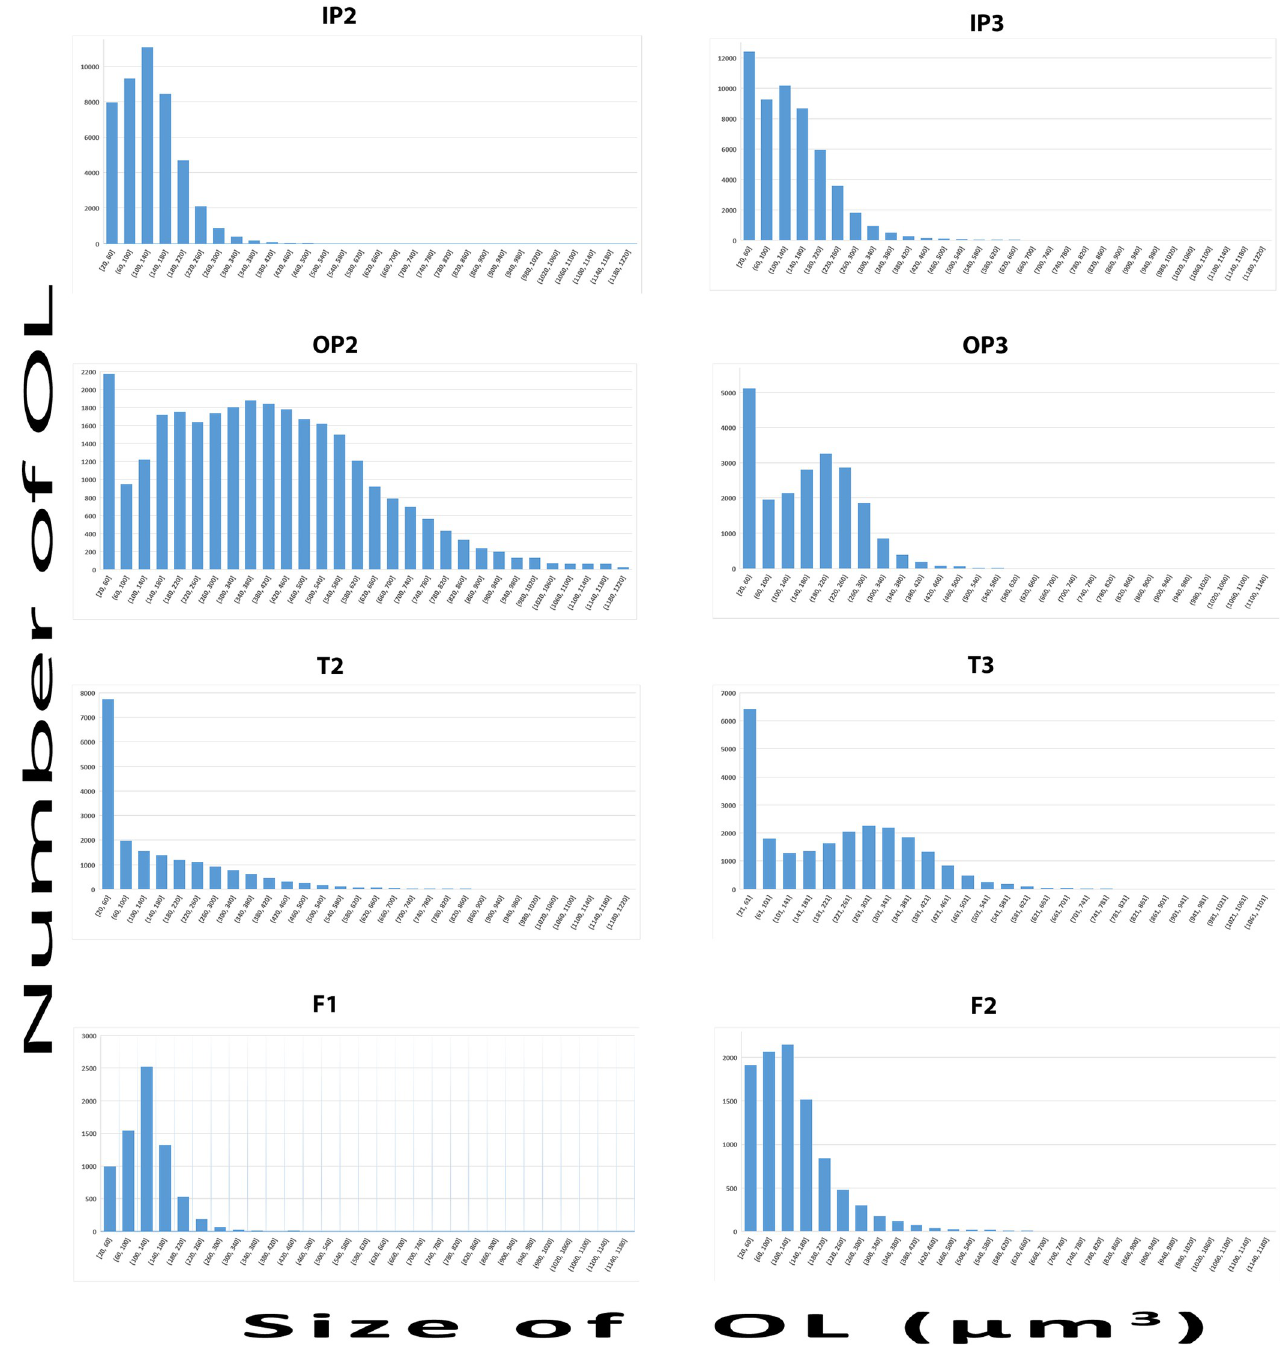
Fig 5. OL volume histograms from all the samples showing the OL volume distribution from 20 to 1200 μ m 3 . OL volume average and standard deviations are provided in Table 2. Note that the unusual distribution of T2 may be due to the poor resolution of the scan (see Methods).